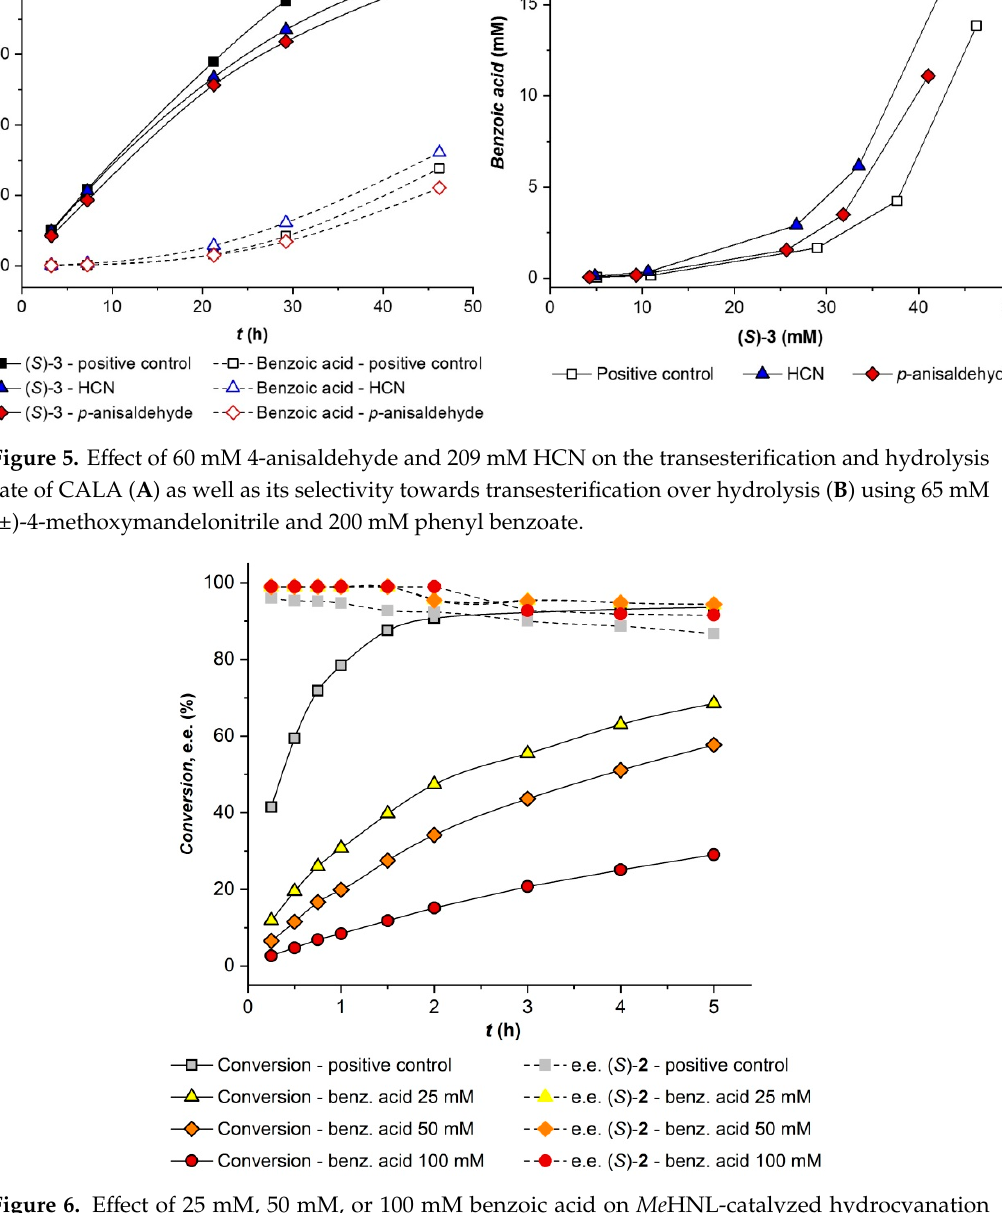
Figure 6. Effect of 25 mM, 50 mM, or 100 mM benzoic acid on Me HNL-catalyzed hydrocyanation of 100 mM 4-anisaldehyde using 6.5 equivalents of HCN. With exception of the positive control, the enantiomeric excess values overlap at low reaction times.